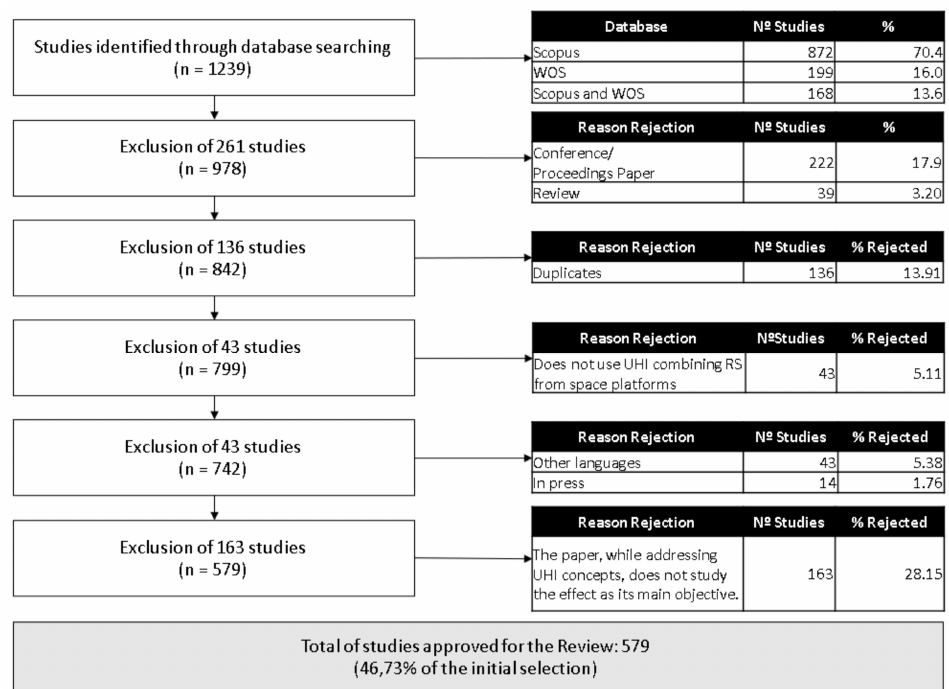
Figure 3. Article selection criteria and approval